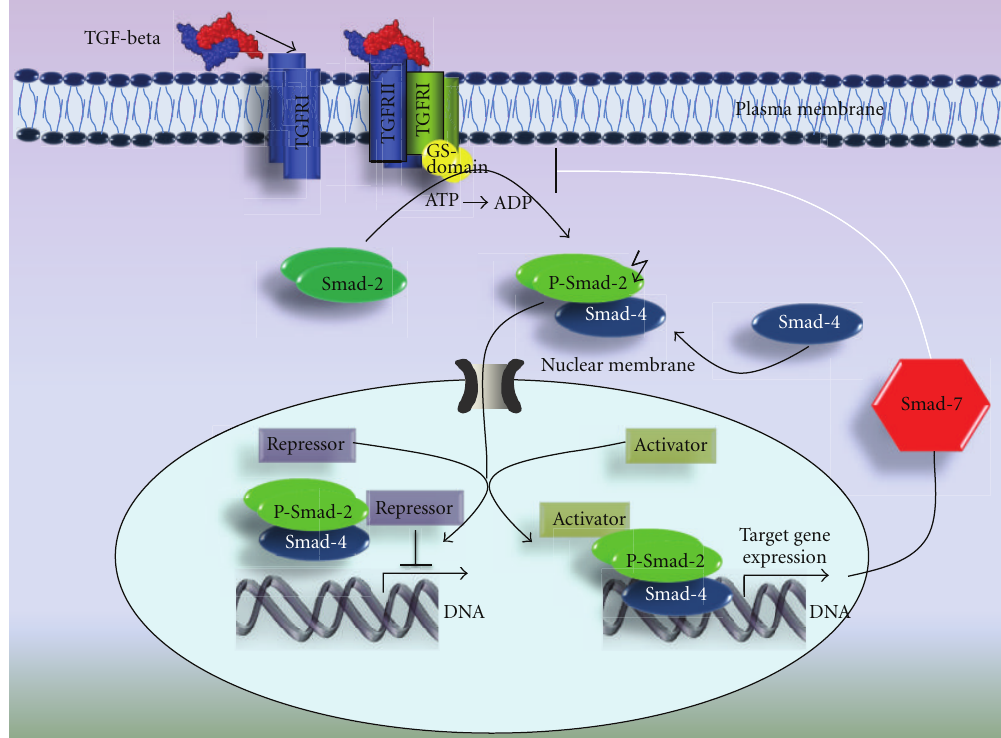
Figure 1: Schematic Illustration: TGF-beta signaling pathway. TGF-beta ligand binds to TGF-betaRII that activates TGF betaRI and induces the downstream Smad-mediated signal